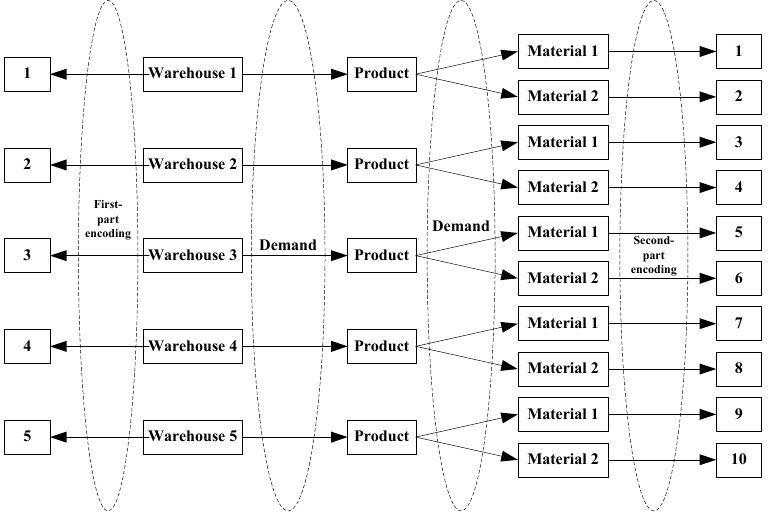
Figure 4. An instance for encoding the materials of